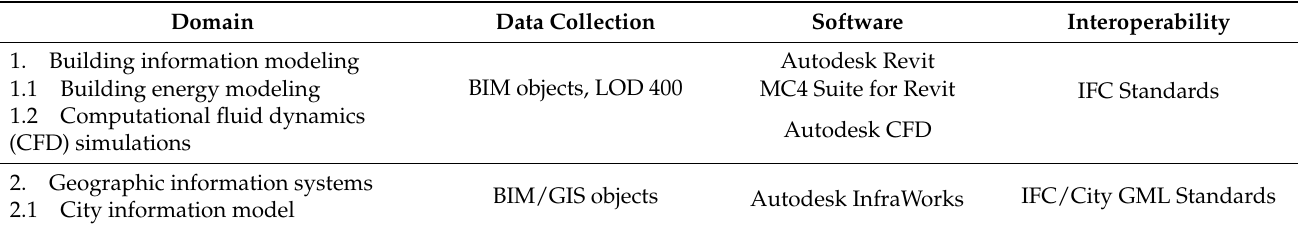
Table 2. Data domains and collection of the interoperability